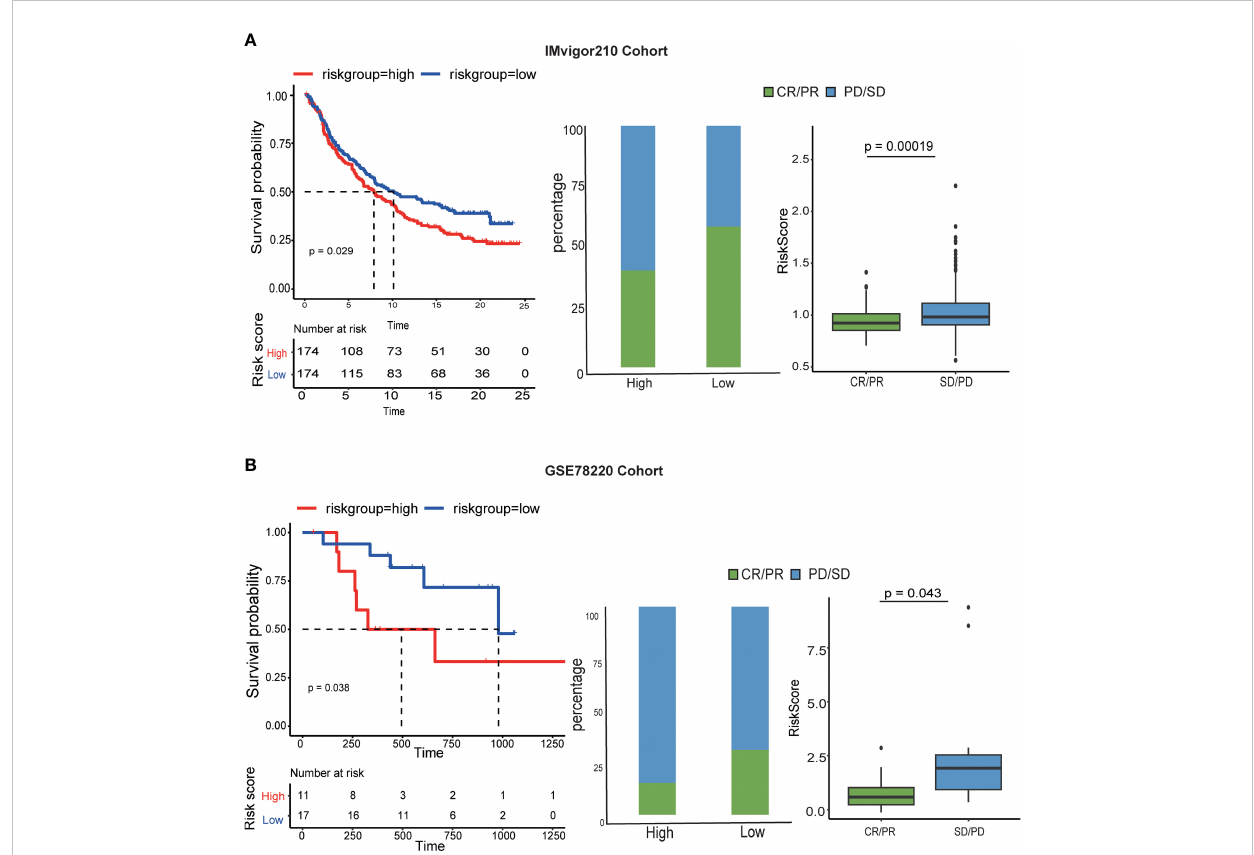
FIGURE 8 Correlation between the LRI score and response to anti-PD-L1 immunotherapy. (A) (a) Differences in L-R scores between responders and nonresponders in the IMvigor210 cohort. (b) The proportion of patients responding to immunotherapy in the high and low L-R score groups in the cohort. (c) Prognostic differences between the high and low L-R score groups in the cohort. (B) (a) Prognostic differences between the high and low L-R score groups in early-stage patients in the GES78220 cohort. (b) Prognostic differences between the high and low L-R score groups in advanced patients in the cohort. (c) L-R score differences between responders and nonresponders in the